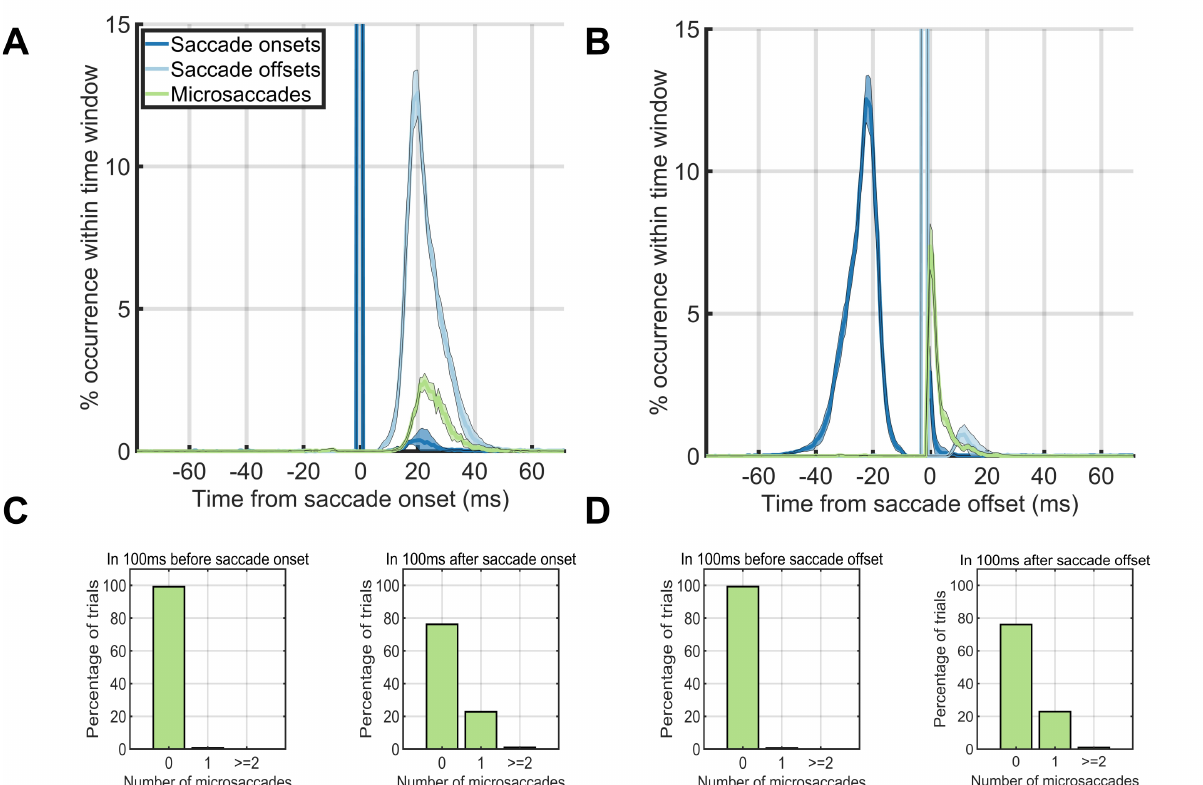
Figure 3. Eye dynamics around the saccade onsets (left column) and saccade offsets (right column). (A, B) Saccade starting times (blue) and ending times (green) plotted against microsaccade starting times (red) when onsets were aligned on saccade onset times (A) and when onsets were aligned on saccade offset times (B). (C, D) The percentage of trials (y-axis) which had 0, 1, or greater than or equal to 2 microsaccades during the first 100ms before saccade onset (left) or during the first 100ms after saccade onset (right) when aligned on the onset time (C) or offset time (D) of the first saccade after trial